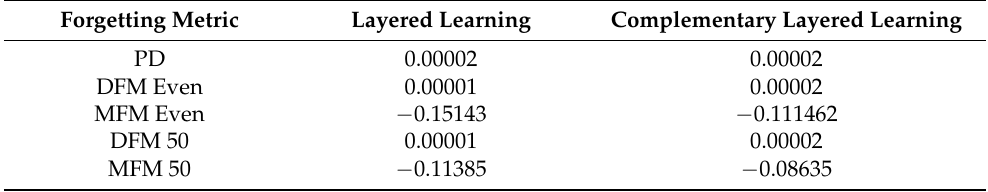
Table 5. EA forgetting metrics for standard vs. complementary layered